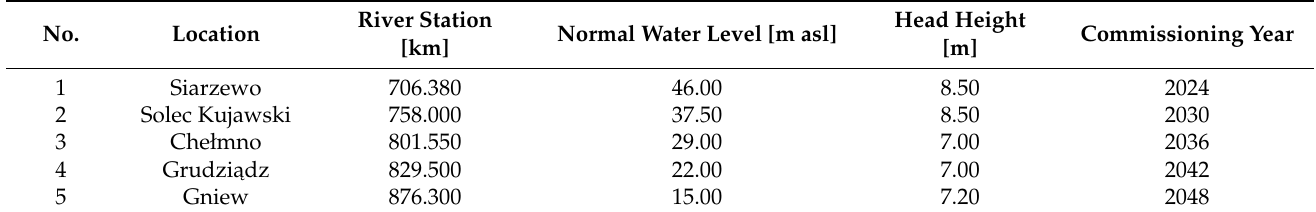
Table 1. Characteristic of water dams planned in years 2024–2048 downstream